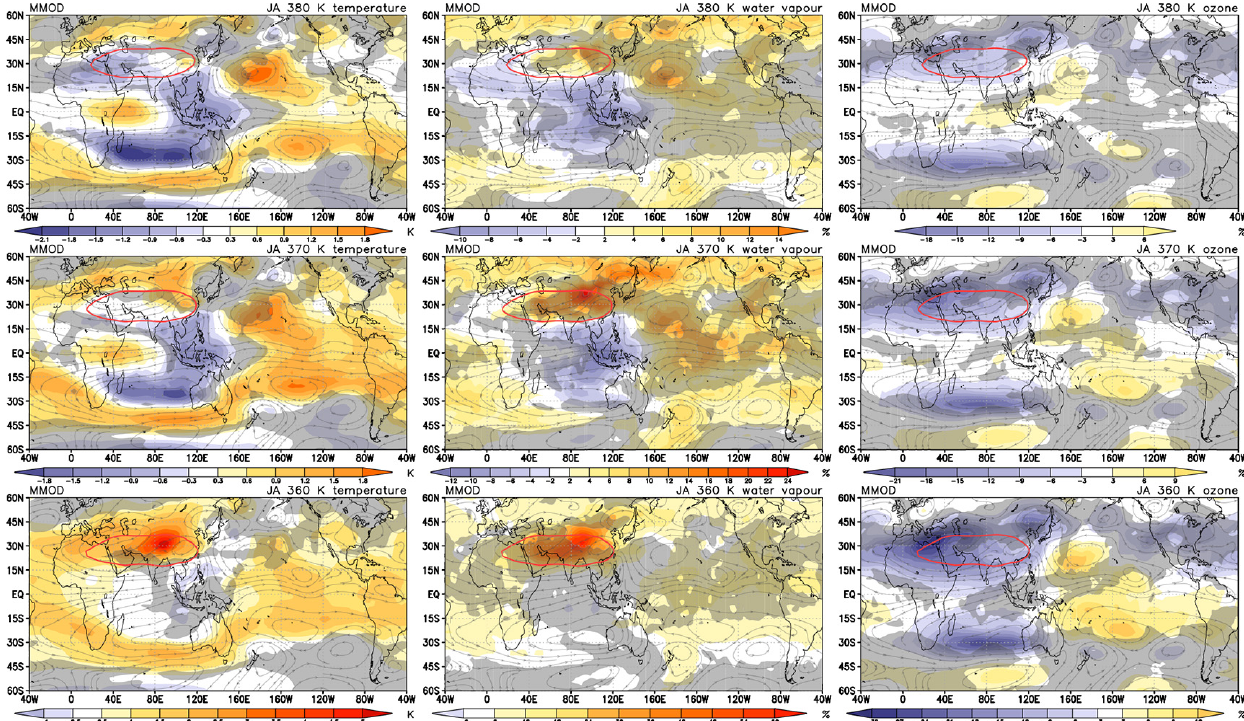
Figure 9. Multi-model average of the CCMs of the regression coefficient of the monsoon circulation index (MIDX) with temperature (left), H 2 O (middle), and O 3 (right) on isentropic levels 360, 370, and 380K (from bottom to top). The regression coefficients of the H 2 O and O 3 mixing ratios are displayed in percent of the long-term average of the respective JA average. Grey streamlines show the horizontal wind components, regressed on the MIDX. The red contours of the Montgomery stream function (360K: 3513, 370K: 3570, 380K: 3625, in 10 2 m 2 s − 2 ) mark the position of the AMA. Overlaid grey shading marks regions where the regression is not significant at the 97.5%